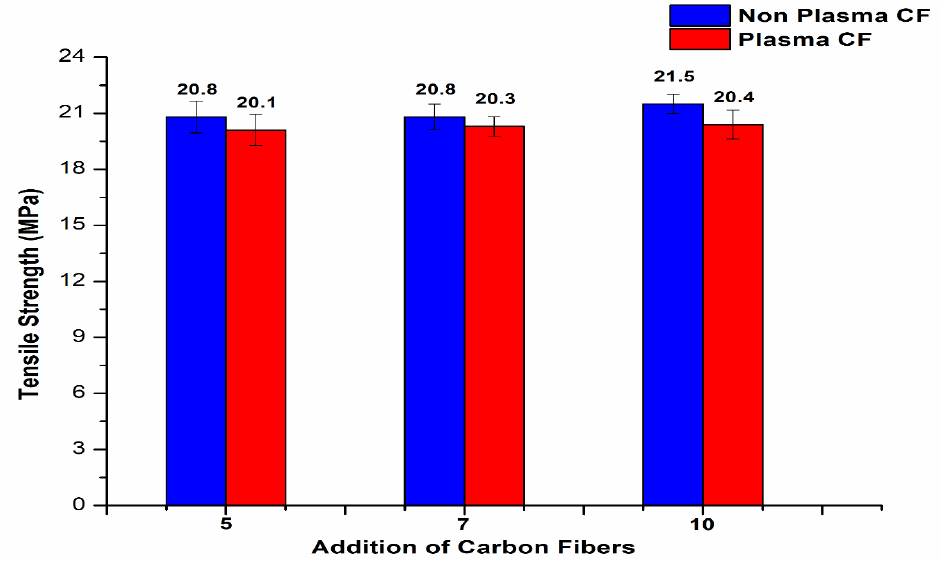
Figure 4. SEM images: ( a ) 5% CF/Plasma PE and ( b ) 10% CF/plasma PE combinations.